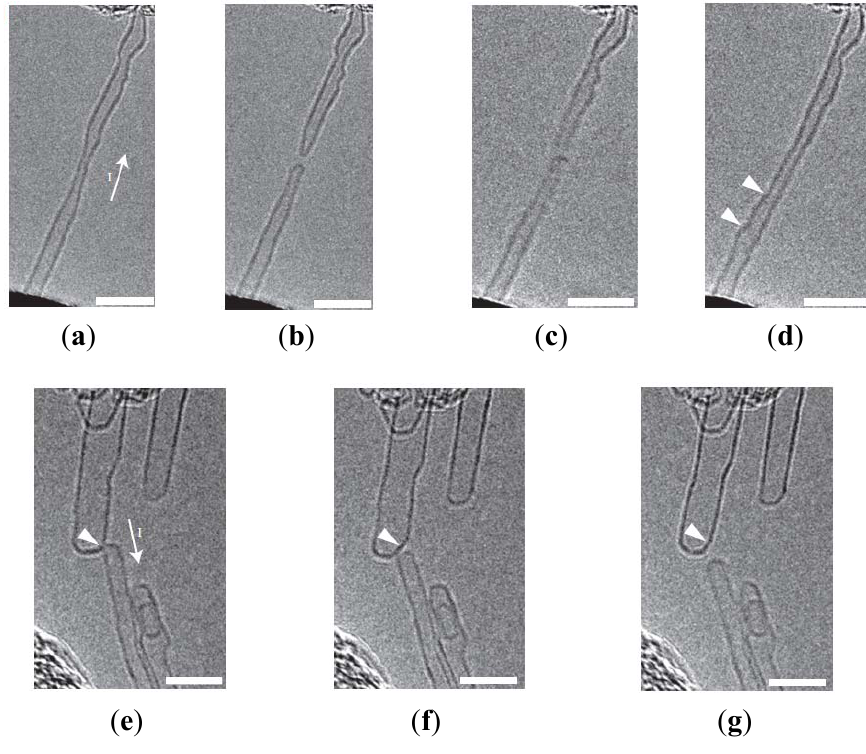
Figure 4. Joining of two CNTs with similar diameter works but fails for two CNTs with different diameters. ( a – d ) Successful joining of a CNT split into two separate CNTs by electrical breakdown ( a , b ). After contacting the two CNTs and applying a large voltage ( c ), the two CNTs bond and a new CNT forms ( d ); ( e – g ) Unsuccessful joining of two CNTs with different diameters. Scale bars are 5 nm in all parts of the Figure. Reprinted with permission from [70]. Copyright (2008) by the Nature Publishing